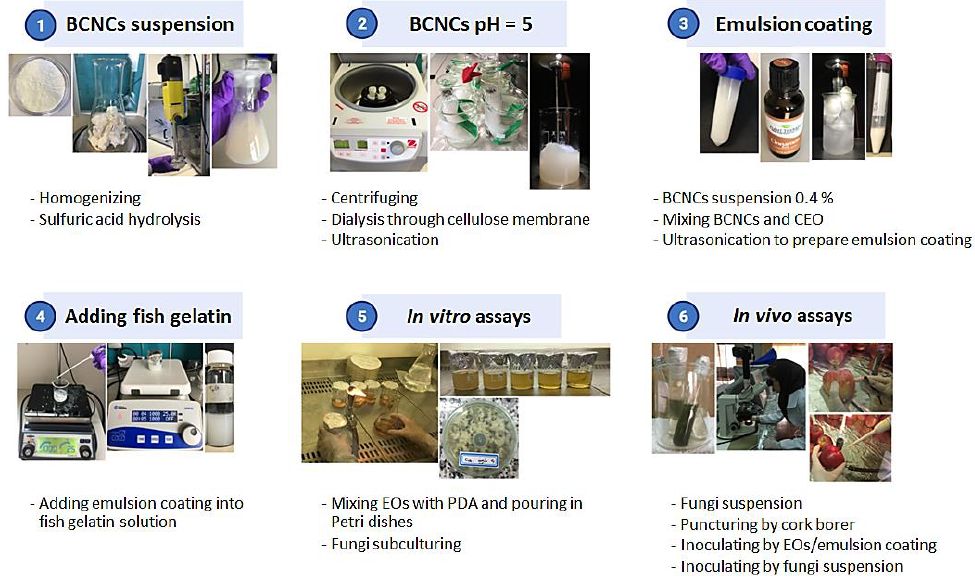
Figure 1. Flow chart of the three-step procedure of the BCNCs/GelA-CEO emulsions manufactur-